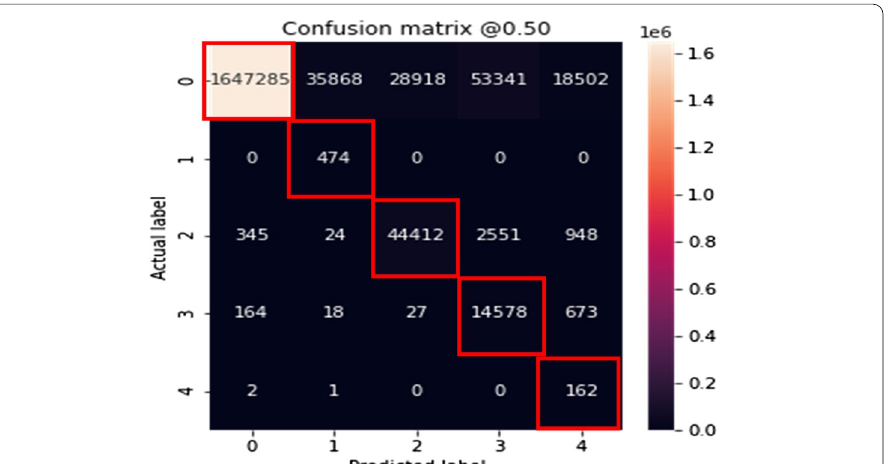
Fig. 7 Confusion Matrix of the 5-class DNN classifier (baseline model)